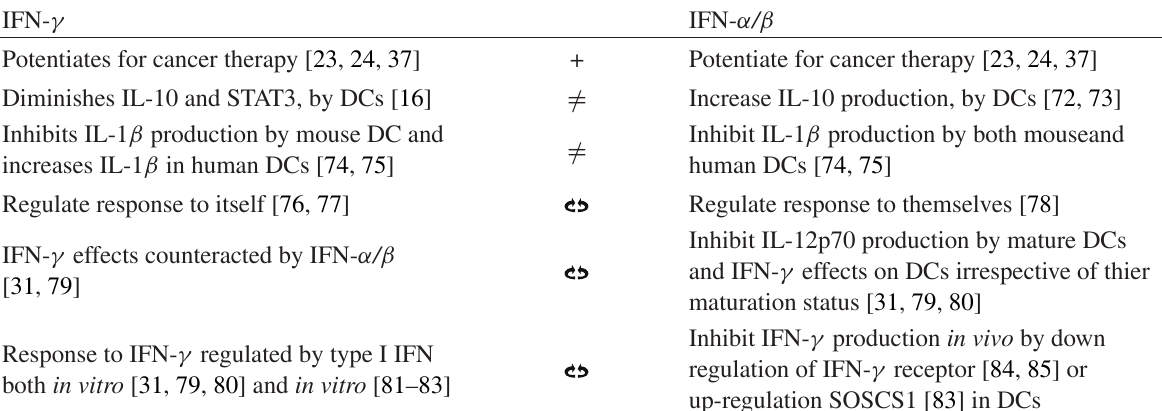
TABLE 2: Type II and I IFN additive, opposite and counter-regulatory effects on dendritic cells. The scheme depicted resumes the most important overlapping, additive, opposite and counter-regulatory effects of type II and I IFNs on DCs. Numbers refer to references reported in the References